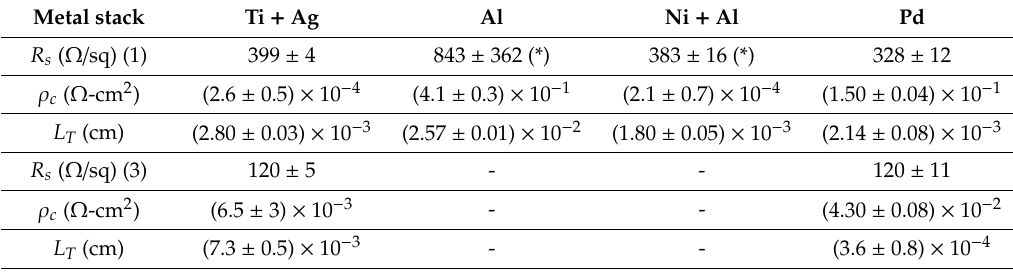
Table 1. Contact resistivity ρ c , current transfer length L T and sheet resistance R s of graphene atomic layers determined for the di ff erent metal stacks tested on graphene monolayer (1) and graphene trilayer (3),